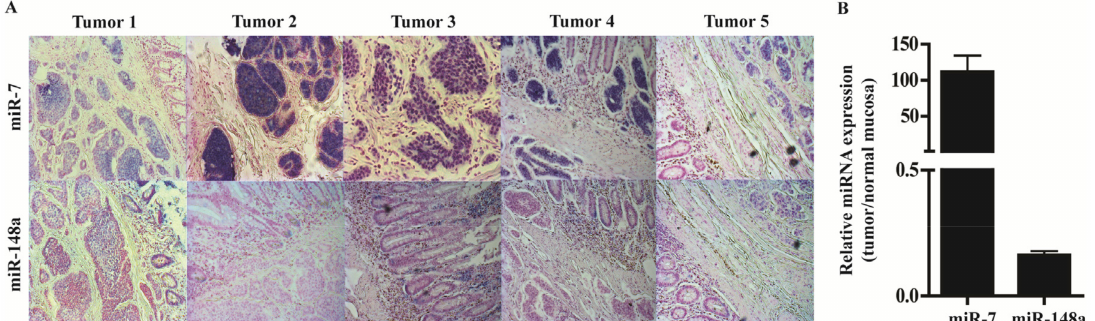
Figure 4. miR-7 and miR-148a are primarily expressed in neuroendocrine cells and inhibit the growth of a carcinoid cell line. ( A ) In situ hybridization of miR-7 show robust expression of miR-7 specifically located to the neuroendocrine cells. The expression of miR-148a is also predominantly seen in the neuroendocrine cells, although to a lesser extent than miR-7. ( B ) qPCR of laser capture micro dissected cells confirmed that miR-7 is robustly expressed in NETs compared to normal mucosa. In contrast, the expression of miR-148a is lower in NETs than in the normal mucosa that contains endocrine cells.